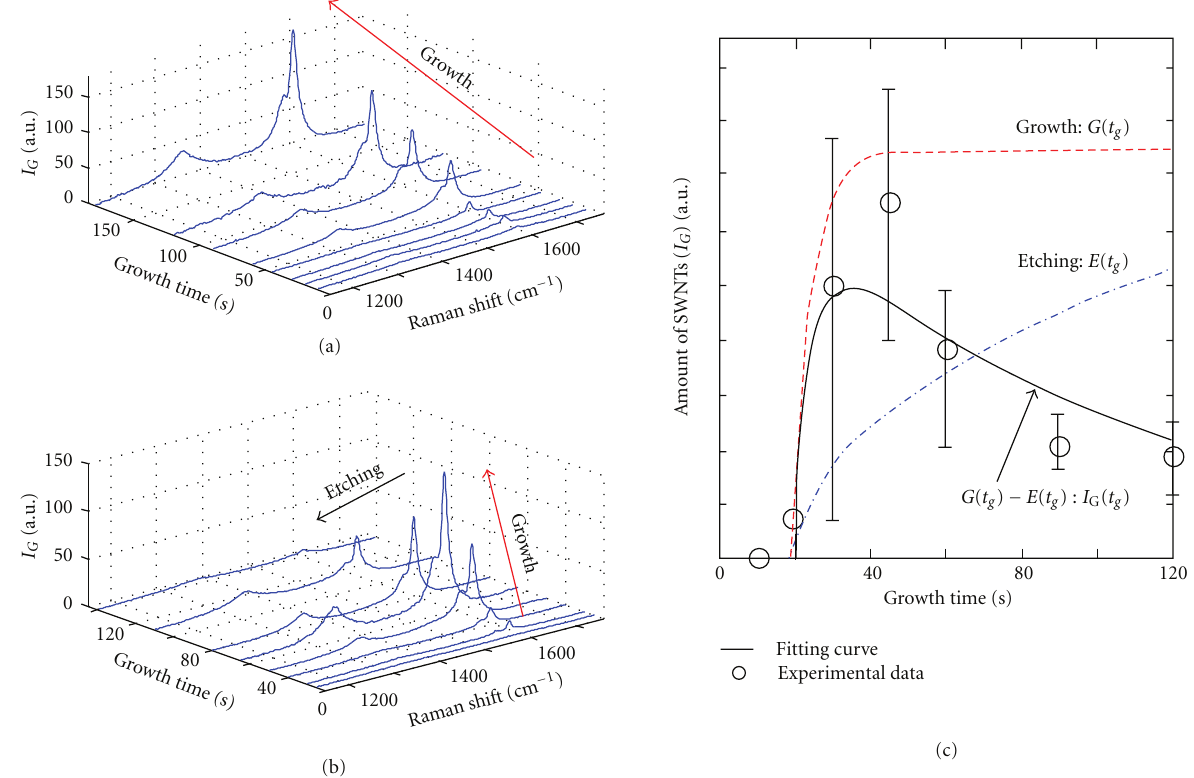
Figure 2: Raman spectra of SWNTs as a function of growth time. (a) P RF = 40 W and (b) P RF = 100 W. (c) Comparison between the experimental data and the fitting curve of (1).